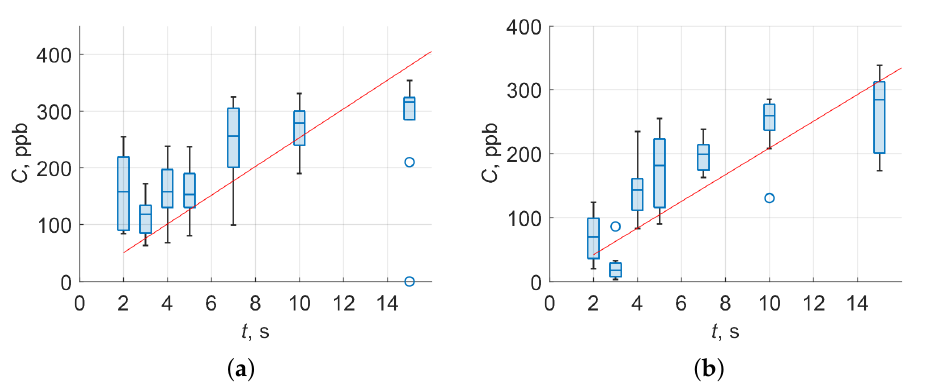
Figure 6. Ethanol ( a ) and acetone ( b ) minimum detectable concentrations for test gas mixtures. Table 2. The molecular cross-section for some